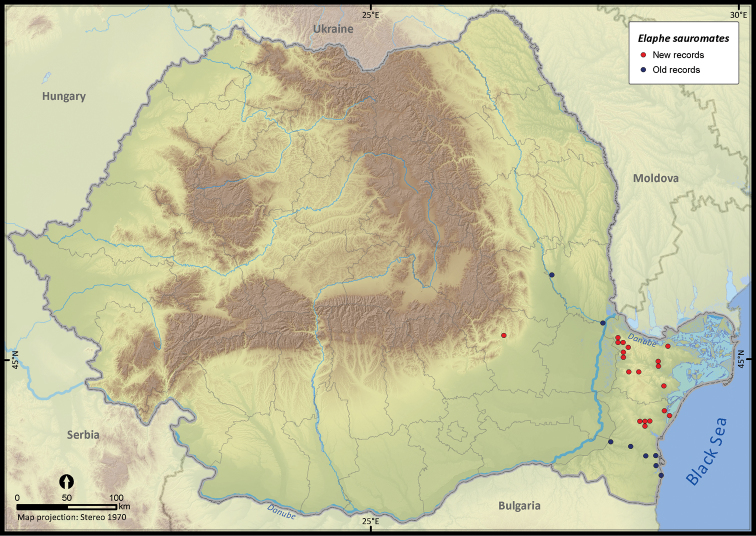
Elaphe sauromates.